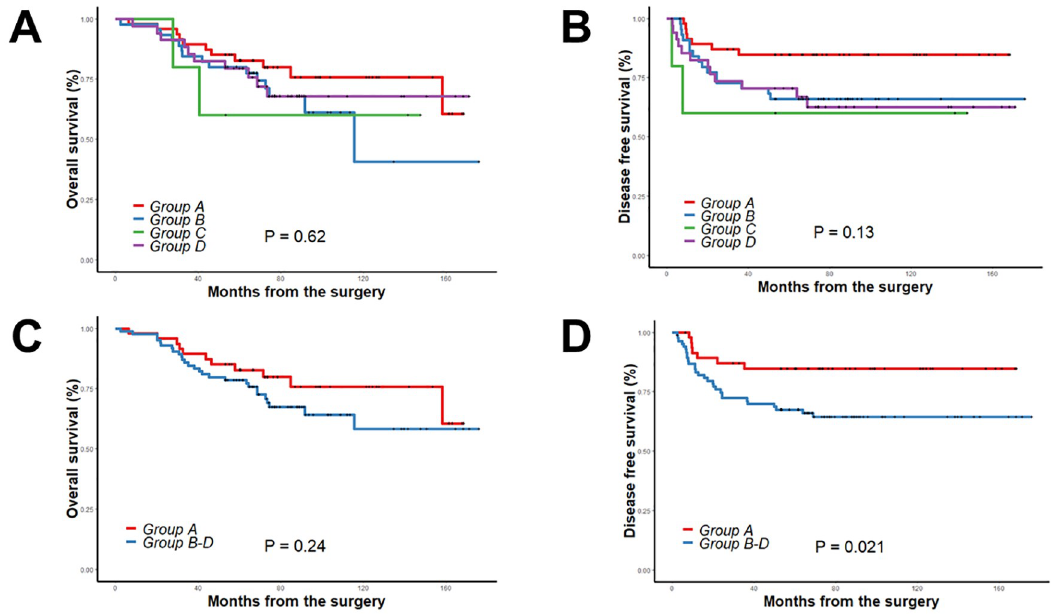
Fig 2. Overall survival and disease-free survival according to combination of pre and post NLRs using cut-off value 3 (A, B) and according to group A versus groups B-D (C, D) in whole cohort (n = 131).